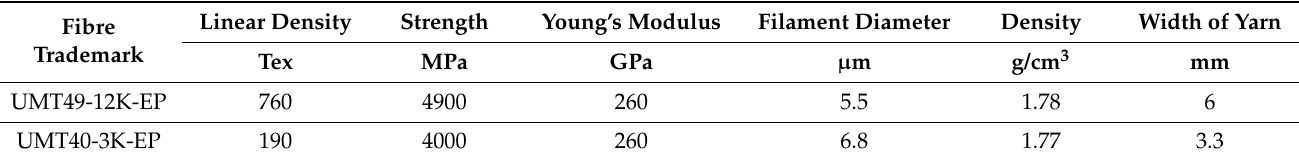
Table 1. Characteristics of fibres.